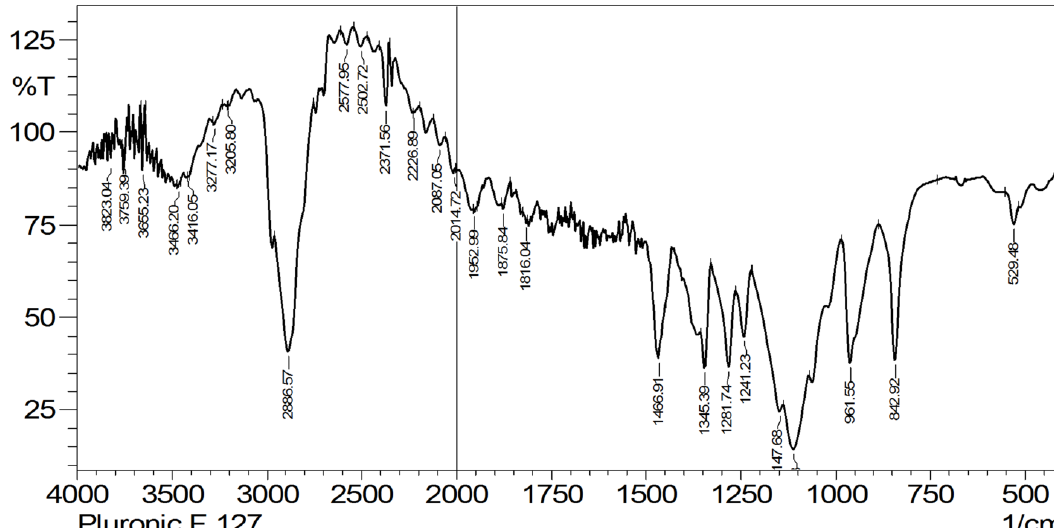
FIGURE 4 - FTIR spectrum of pluronic